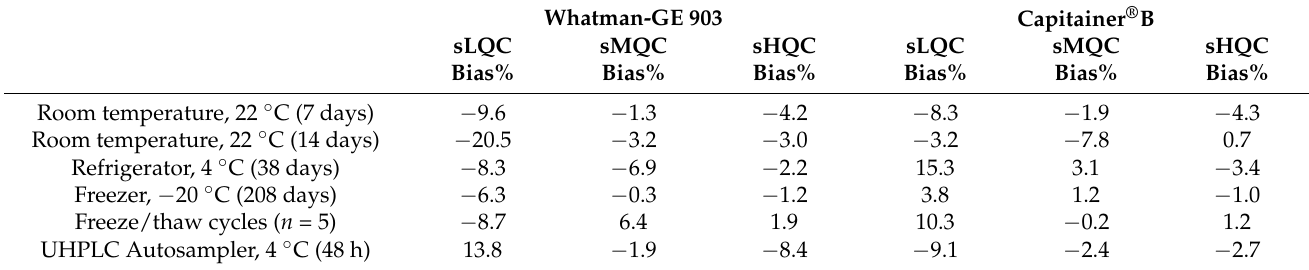
Table 7. Stability assays ( n = 2) performed with spiked quality control (sQC) dried blood spots